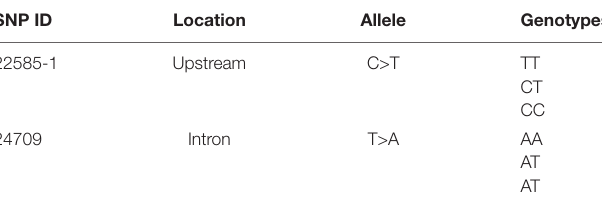
TABLE 1B | Two SNPs differentiated in gene expression allele by